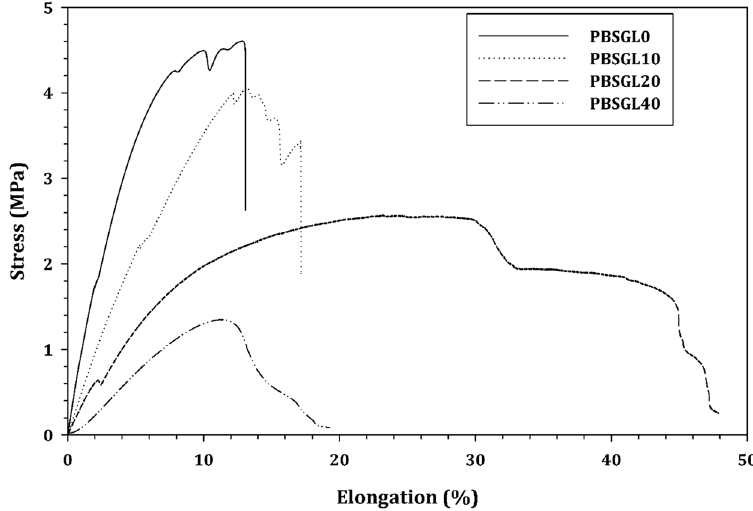
Figure 6. Tensile stress-strain curves of PBSGL n electrospun nanofibers.